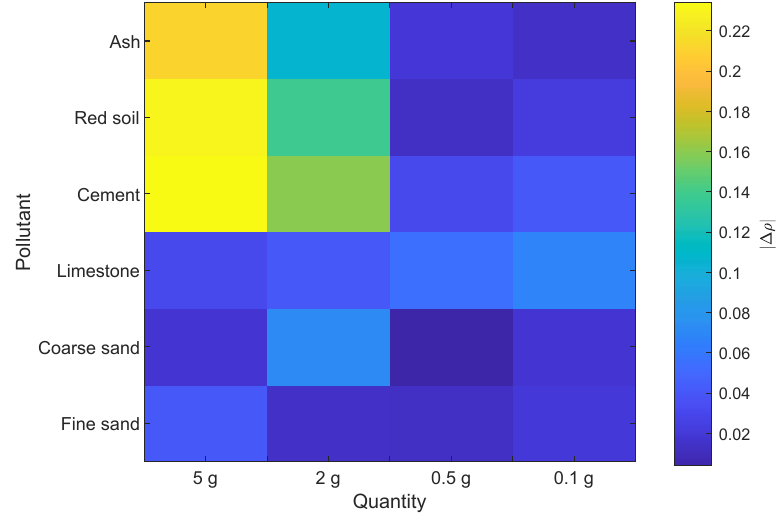
Figure 11. Reflectivity differences between polluted and clean